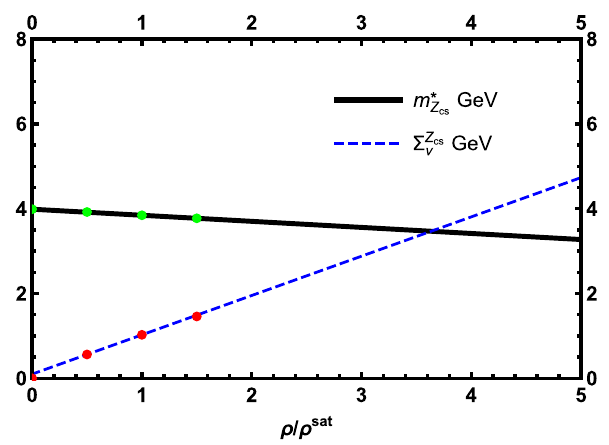
Fig. 3 The dependence of m ∗ and (cid:10) υ on ρ/ρ sat at mean values of Z cs the continuum threshold and Borel parameter. The green and red points denote the results obtained from the in-medium sum rules, while the solid and dashed lines represent the fit